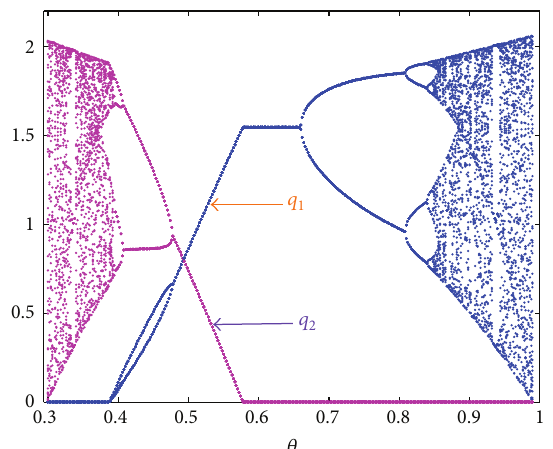
Figure 9: Bifurcation diagram of system (6) with 𝜃 ∈ (0.2937, 1] and 𝛼 1 = 1.02 and 𝛼 2 = 1.46 .